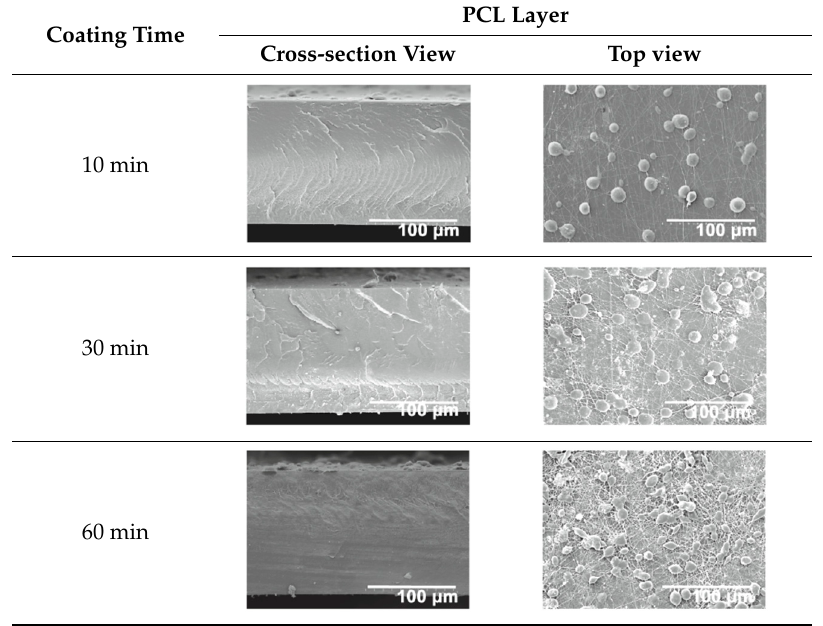
Table 3. Field emission scanning electron microscope (FESEM) micrographs of the cryofractured cross-sections and top views of the nanostructured multilayer films of low-density polyethylene (LDPE), coated with electrospun ultrathin poly( ε -caprolactone) (PCL) fibers and electrosprayed silica (SiO 2 ) microparticles. The PCL fibers were deposited at different time intervals, namely 10, 30, and 60 min, and later subjected to annealing. The SiO 2 deposition time was kept constant at 1 h.